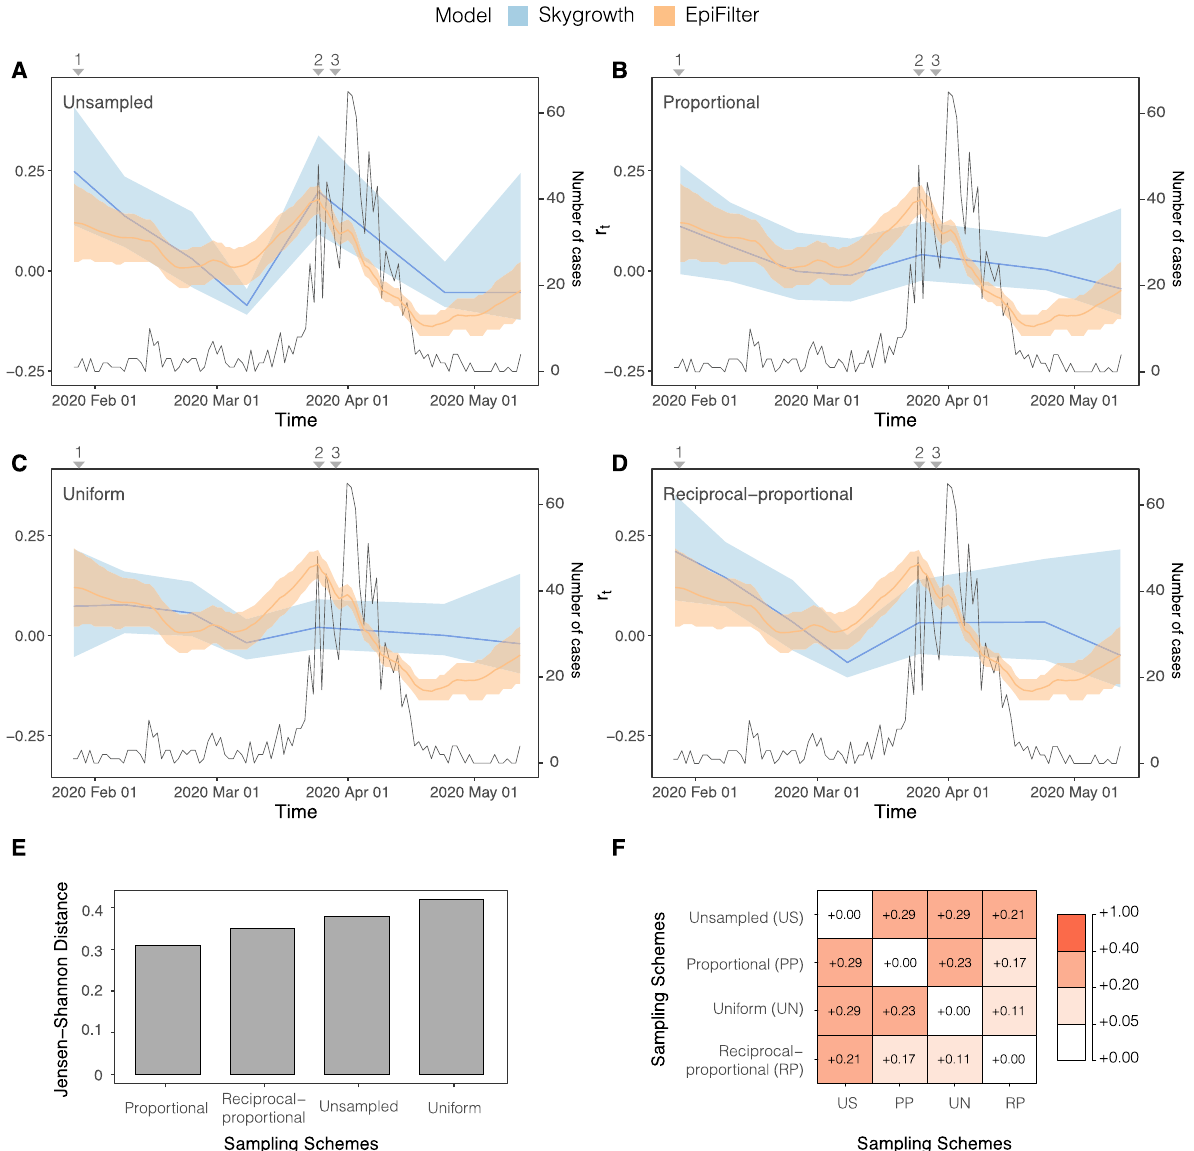
Fig. 5 | r t estimated from both the Skygrowth and EpiFilter methods for Hong Kong. Titles indicate the sampling scheme used in panels A – D . The light-shaded arearepresentsthe95%highestposteriordensityinterval.Thesolidlinerepresents the mean r t estimate with EpiFilter in orange and Skygrowth in blue. The black line referstothenumberofcases.WerefertoFig.1forabriefdescriptionofkeyevents